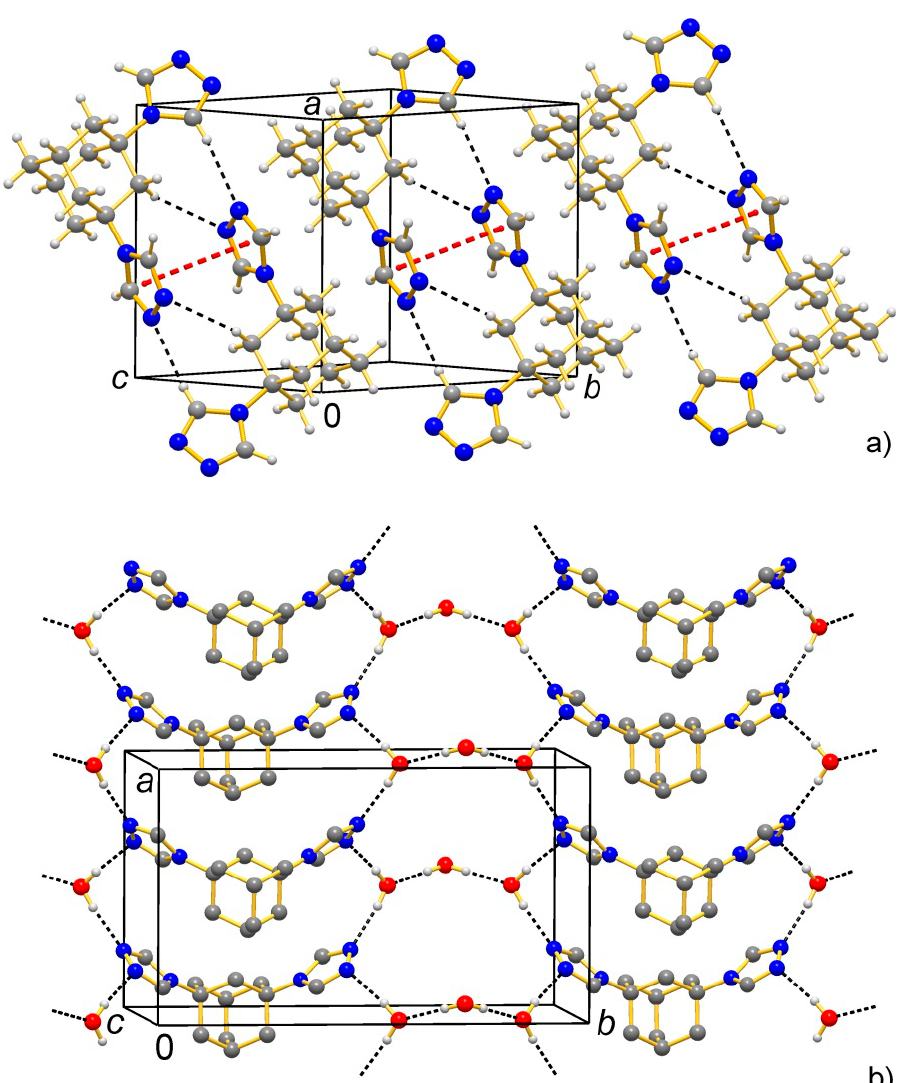
Figure 3. Representation of portion of the crystal structure of ( a ) tr 2 ad and ( b ) tr 2 ad ∙ 3H 2 O, showing the principal supramolecular motifs created by non-bonding interactions involving the triazole nitrogen atoms as acceptors: ( a ) multiple CH ∙∙∙ N interactions (black dashed lines) concur with π / π stacking interactions (red dashed lines) to form tr 2 ad dimers; ( b ) OH ∙∙∙ N and OH ∙∙∙ O hydrogen bonds (black dashed lines) support the formation of 2-D supramolecular layers. Atoms colour code: C, grey; H, light grey; N, blue; O,